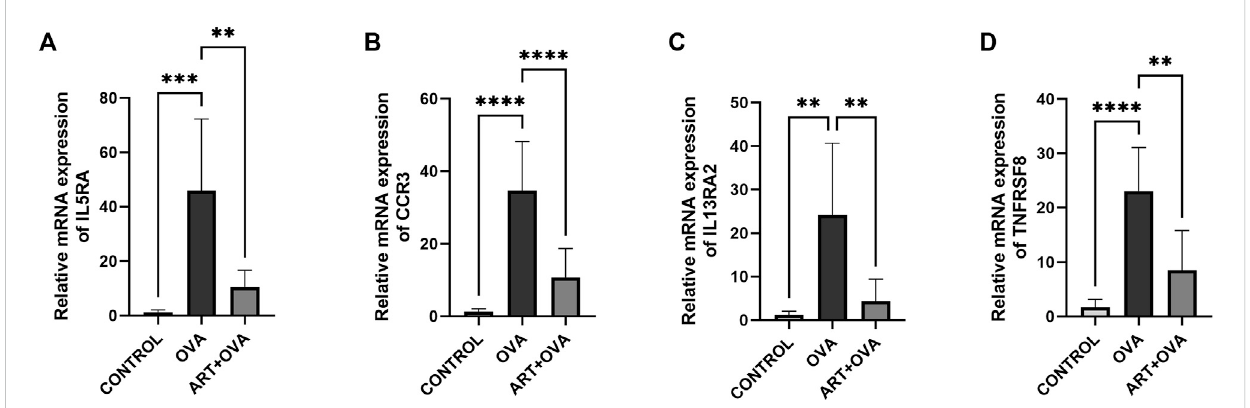
FIGURE 7 Effect of ART on OVA-induced asthma on mRNA expression levels. (A – D) Relative mRNA expression of IL5RA, CCR3, IL13RA2, TNFRSF8 in three groups: control, asthma (OVA), and ART + asthma (ART + OVA) group ( n = 6). * p < 0.05, ** p < 0.01, *** p < 0.001, **** p < 0.0001.